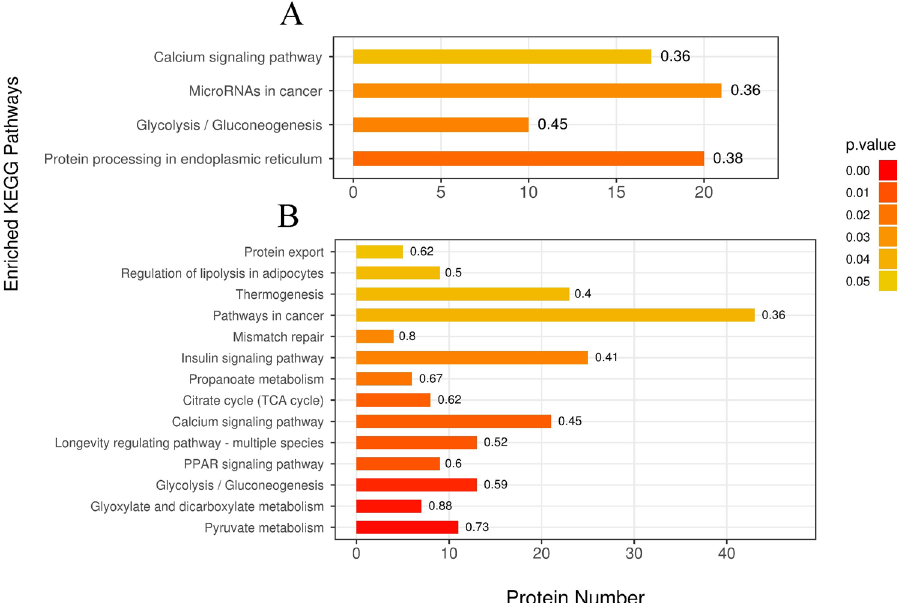
Figure 7. KEGG pathway enrichment analysis of phosphoproteomics treated with PZH ( A ) and sora ( B ). The ordinate represents the significantly enriched KEGG pathway, the abscissa represents the number of differentially expressed proteins contained in each KEGG pathway. The color gradient represents the size of the P value, the closer to red, the smaller of p value, which corresponds to the enrichment degree of the KEGG pathway. The label above the bar graph shows the enrichment factor which indicates the ratio of differentially expressed phosphorylated proteins to the identified phosphorylated proteins involved in the pathway.